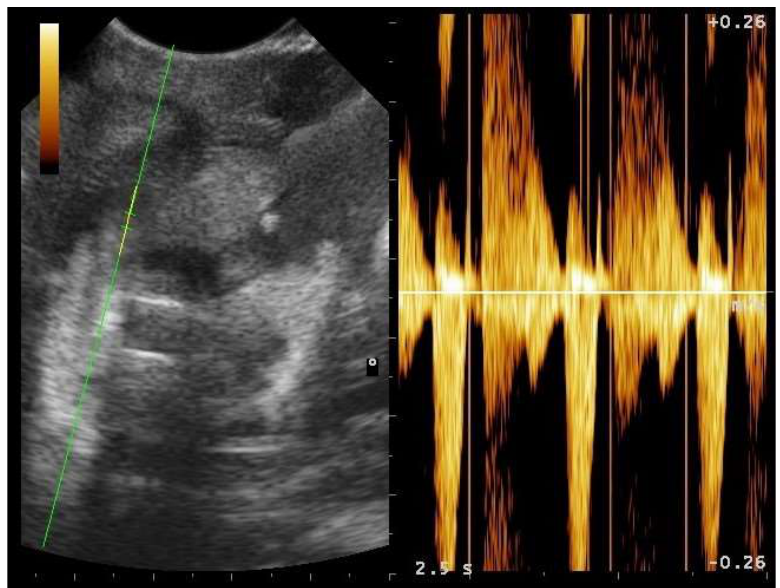
Figure 17. Gravid female boa 33 days before parturition. In all females who have given birth to live offspring, fetal heart was recognized in the first third of the total fetal body length. The sample volume was placed on the embryonic heart, and fetal heart activity was assessed considering heart rate and heart morphology. On the right, the arterial flow is highlighted; in particular, it is possible to observe the systolic peak and the diastolic peak.